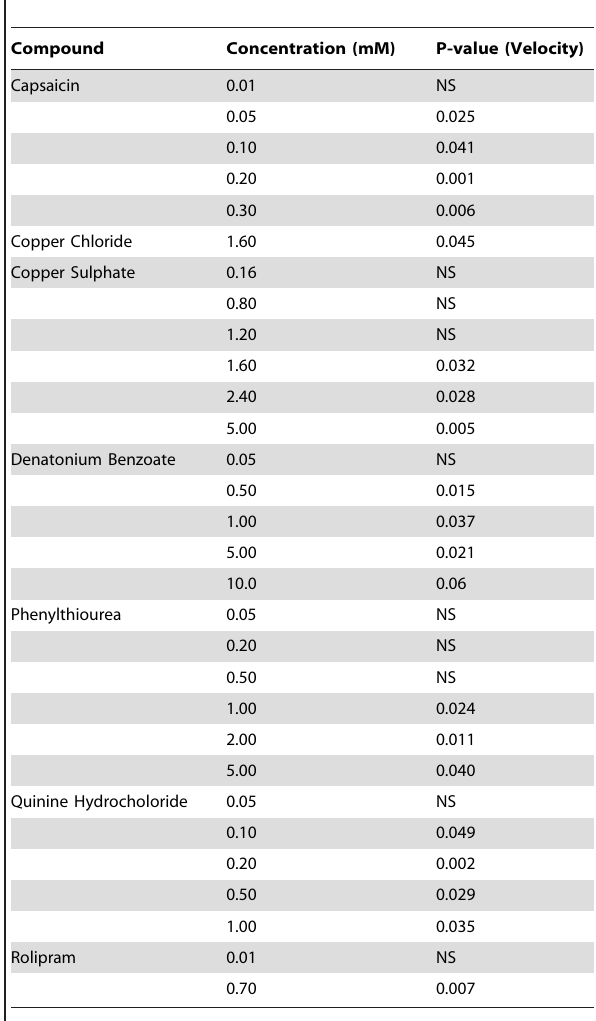
Table 2. Statistical significance of the concentration- dependent acute reduction in Dictyostelium cell